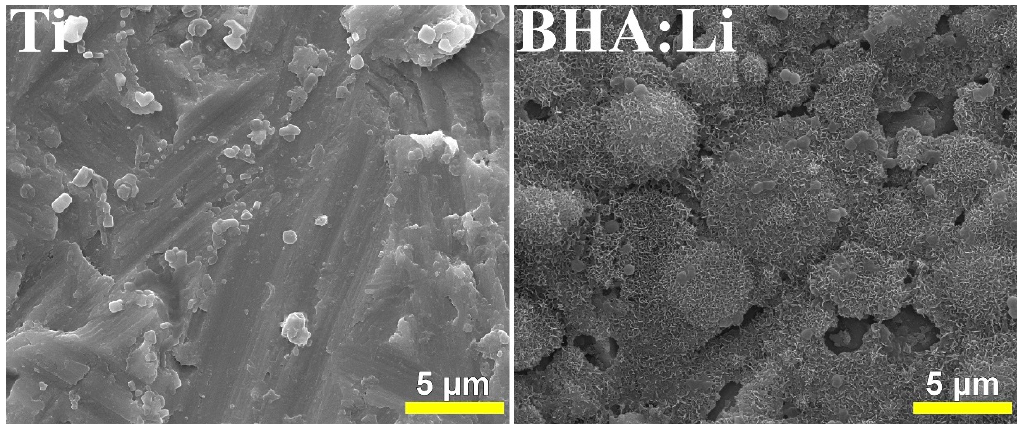
Figure 10. SEM images corresponding to S. aureus biofilm after 72 h of development on the surfaces of Ti and bovine hydroxyapatite doped with Li 2 O coatings.